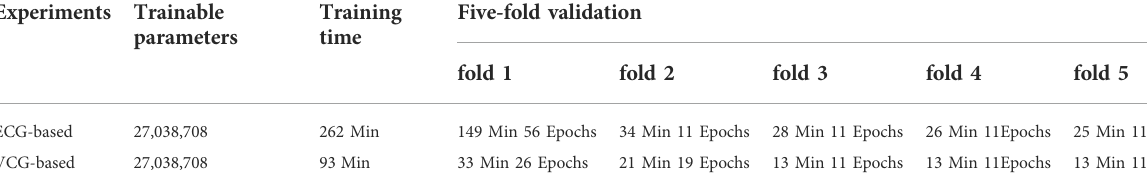
TABLE 4 Training information of the ECG-based and the VCG-based 3DRP methods. Experiments Trainable